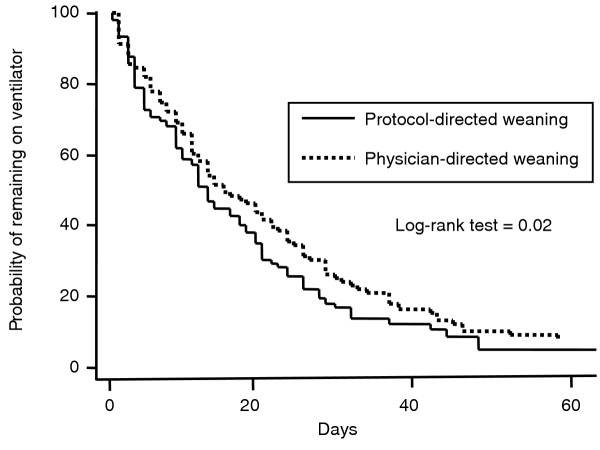
Kaplan–Meier curves of the risk for remaining mechanically ventilated in protocol-directed (cases) versus physician-directed weaning groups (controls). The protocol-directed weaning procedure allowed reduction in the overall duration of mechanical ventilation, whatever the patient's diagnosis. The overall mechanical ventilation duration was 16.6 ± 13 days in cases and 22.5 ± 21 days in controls (P = 0.02).